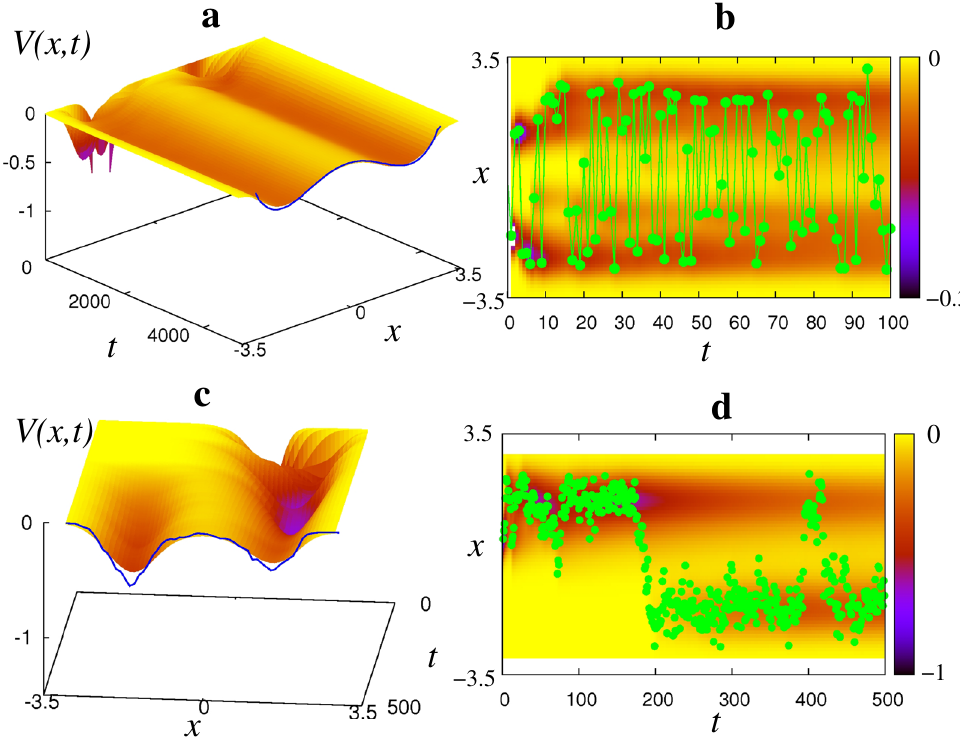
Figure 3. “Learning” energy landscape with simulated stimuli. Evolution of the energy landscape V ( x , t ) as the random stimulus is applied by numerically simulating equation (13) with k = 0: ( a , c ) 3D view; ( b , d ) projection of V ( x , t ) onto ( x , t ) plane shown by color, and the stimulus applied–by filled circles. In ( a , c ) the probability density distribution of stimulus is given by solid line at the front. In ( a , b ) the consecutive values of the stimulus are uncorrelated, and in ( c , d